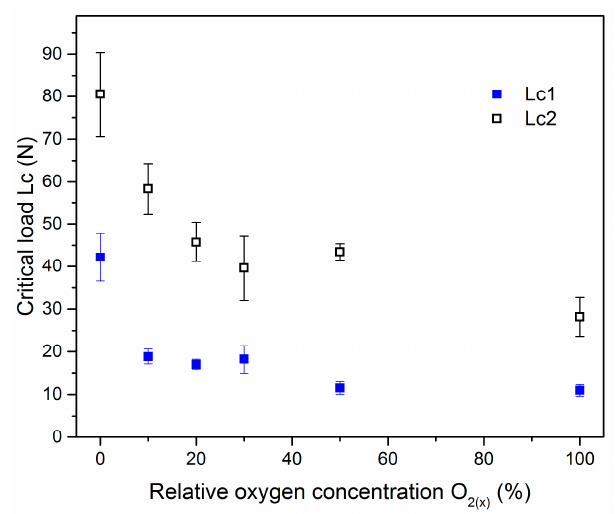
Figure 11. The critical loads for Zr-O-N coatings deposited at different O 2(x) .